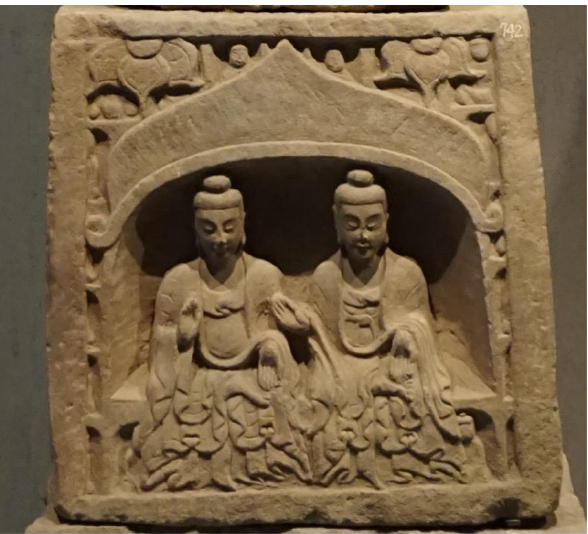
Figure 7. Twin Buddhas. On a Nannieshui Pagoda, scene no. 742. Early sixth century, Northern Wei. Shanxi province. Nannieshui Museum. Photograph taken by the author.